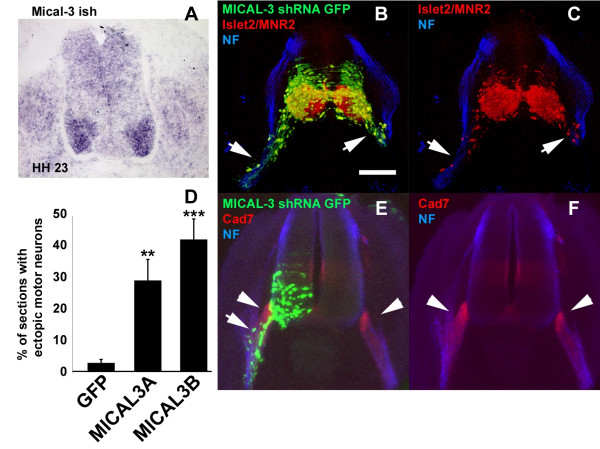
Knockdown of MICAL3 by ventral targeted shRNA-EGFP induces large scale ectopic migration of spinal motor neurons. (a) In situ hybridisation on HH stage 23 chick embryo transverse cryosections shows distinct expression of MICAL3 in motor neurons. (b,c) Targeting of MICAL3 shRNA-EGFP in the ventral spinal cord induces large scale ectopic migration of dual labelled GFP-positive (green (b)) Islet2/MNR2 positive (red (b,c)) motor neuron somata into ventral root (white arrows in (b,c)). The section was counterstained with anti-neurofilament (NF; blue) to locate the dorsal and ventral roots and show the specific, ventral targeting of the electroporation. (d) The percentage of vibratome sections from HH stage 24 embryos containing dual labelled EGFP- and MNR2/Islet2 positive ectopic motor neurons out of the total of EGFP-positive sections, after ventral electroporations with two shRNA-EGFP constructs MICAL3-A and -B, is significantly higher than when EGFP alone was electroporated. ***P < 0.001; two-tailed t-test. (e,f) Cad-7 expressing BC cells at the MEP (red; white arrowheads) are unaffected by MICAL3 shRNA knock down in the ventral spinal cord (green in (e)) that induces large scale motor neuron migration (arrow in (e)). Bar = 100 μm.